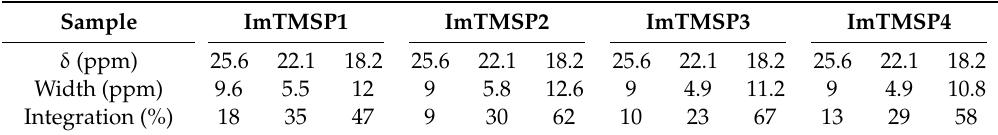
Table 4. Parameters used for the simulation of 31 P MAS NMR spectra of γ -Al 2 O 3 grafted with ImTMSP. Sample ImTMSP1 ImTMSP2 ImTMSP3 ImTMSP4 δ (ppm) Integration